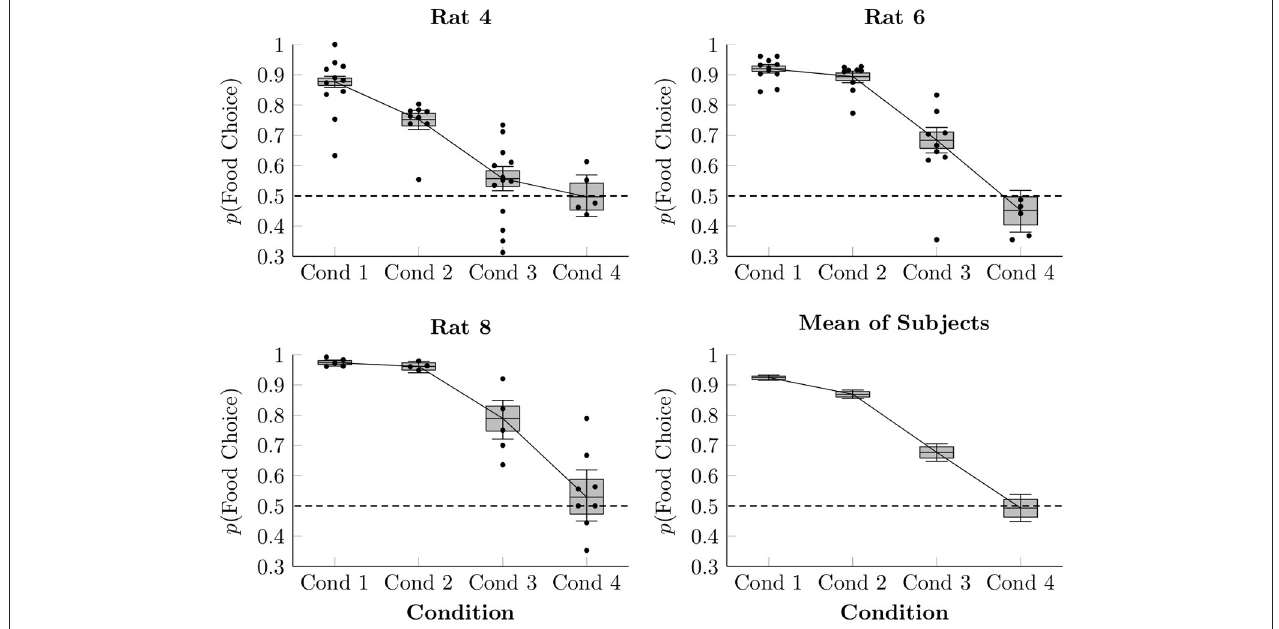
FIGURE 2 | Estimated proportion of food choices made for each of the rats in Conditions 1–4 based on a multi-level logistic regression, as well as observed proportions. The proportion of social choices was complementary to the food choices, such that p (cid:0) Social Choice (cid:1) = 1 − p (cid:0) Food Choice (cid:1) . Points represent observed means for each session, whereas boxes represent the 80% credible interval and whiskers represent the 95% credible interval of the estimated proportion.